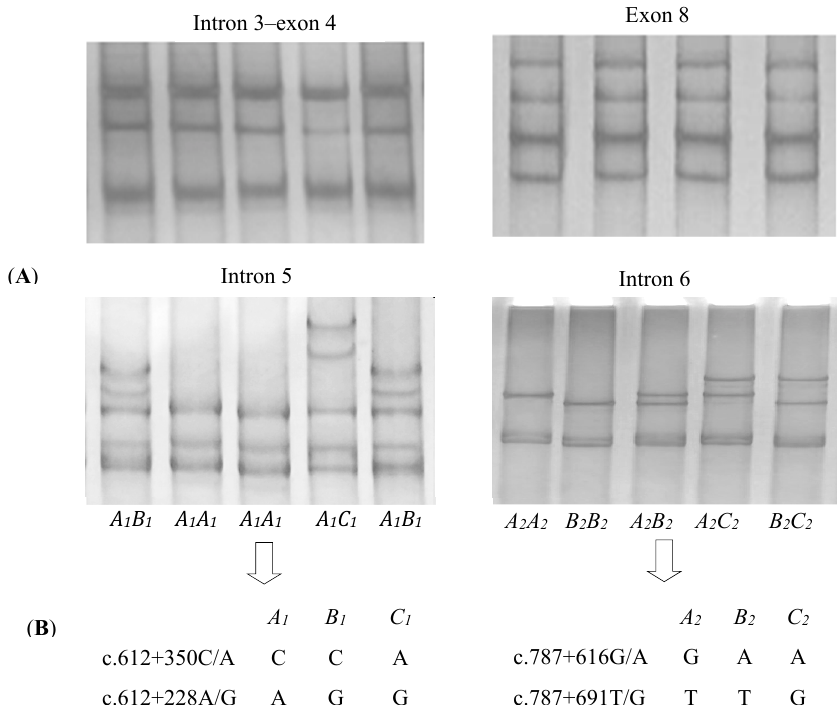
Figure 1. SSCP (single-stranded conformational polymorphism) banding patterns for the four regions of yak DGAT2 amplified ( A ) and single-nucleotide polymorphisms (SNPs) detected in introns 5 and 6 of yak DGAT2 ( B ).